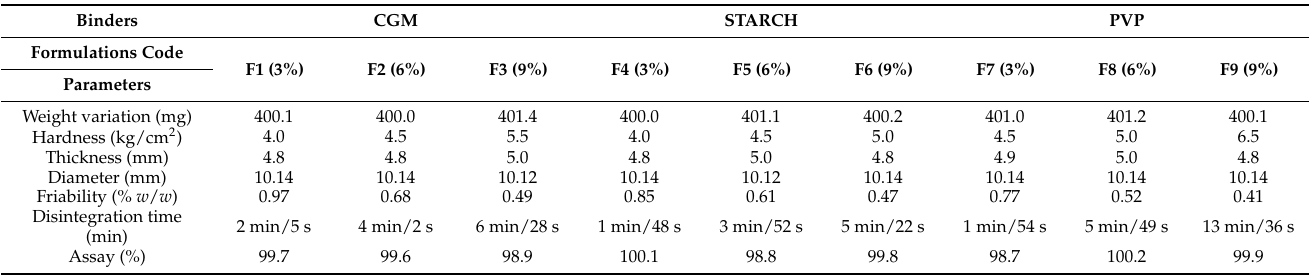
Table 9. Evaluation of tablets using different binding